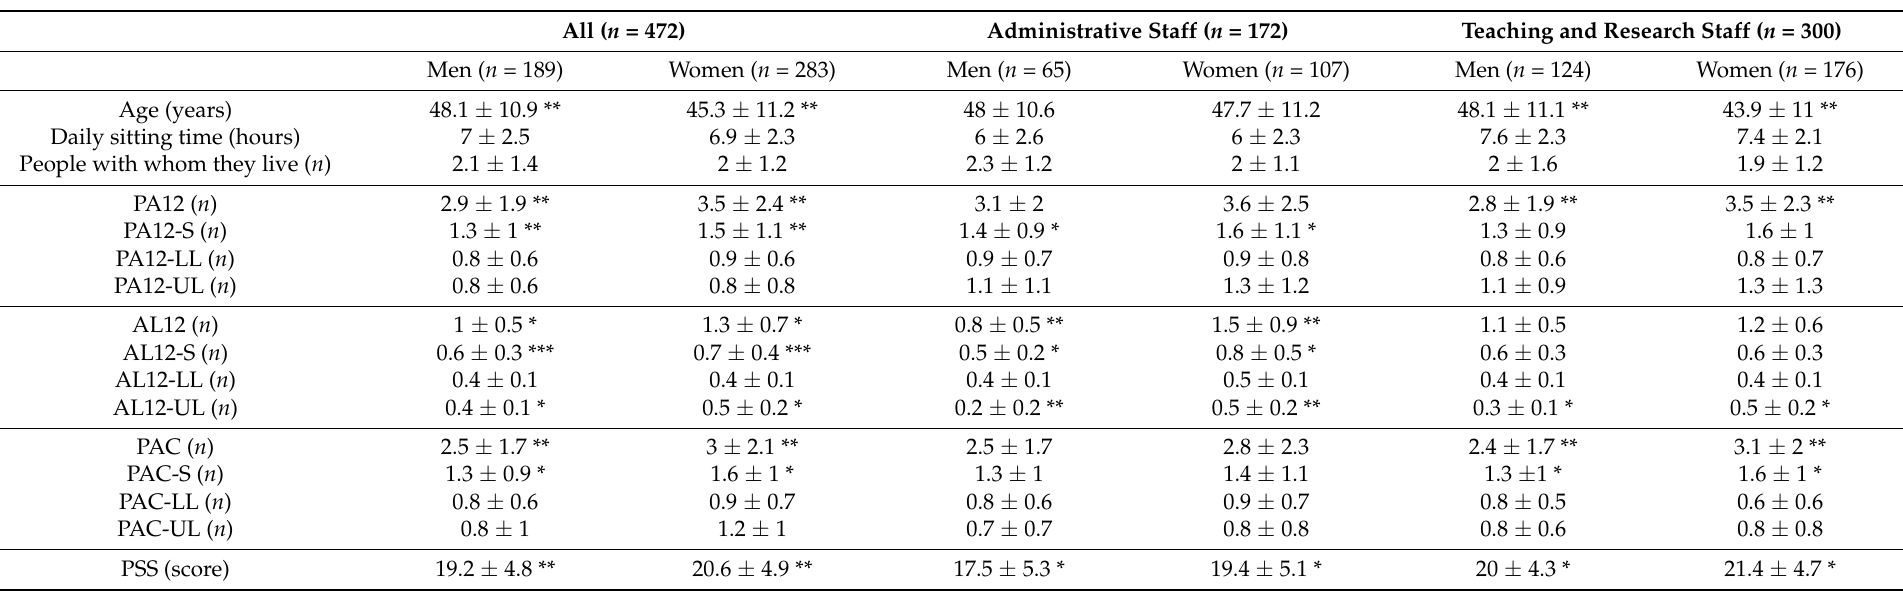
Table 1. Descriptive statistics of the sample (data provided: mean ± standard